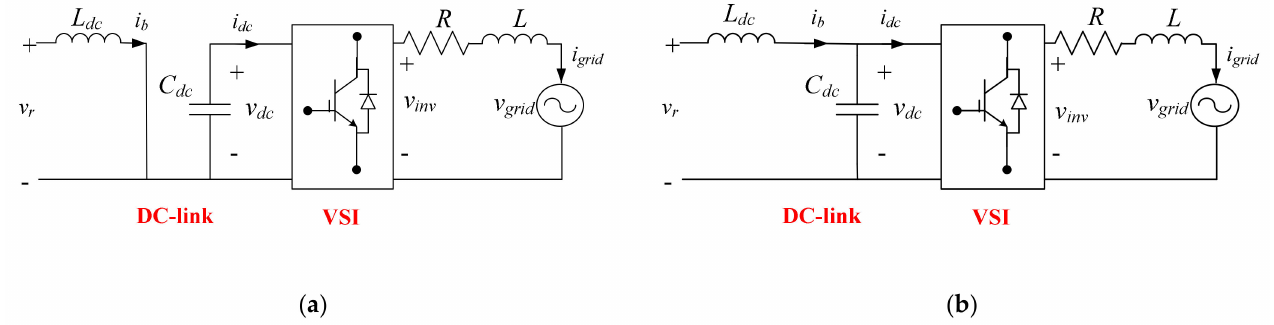
Figure 3. System’s sub-model circuits when SW1 is ( a ) ON and ( b )